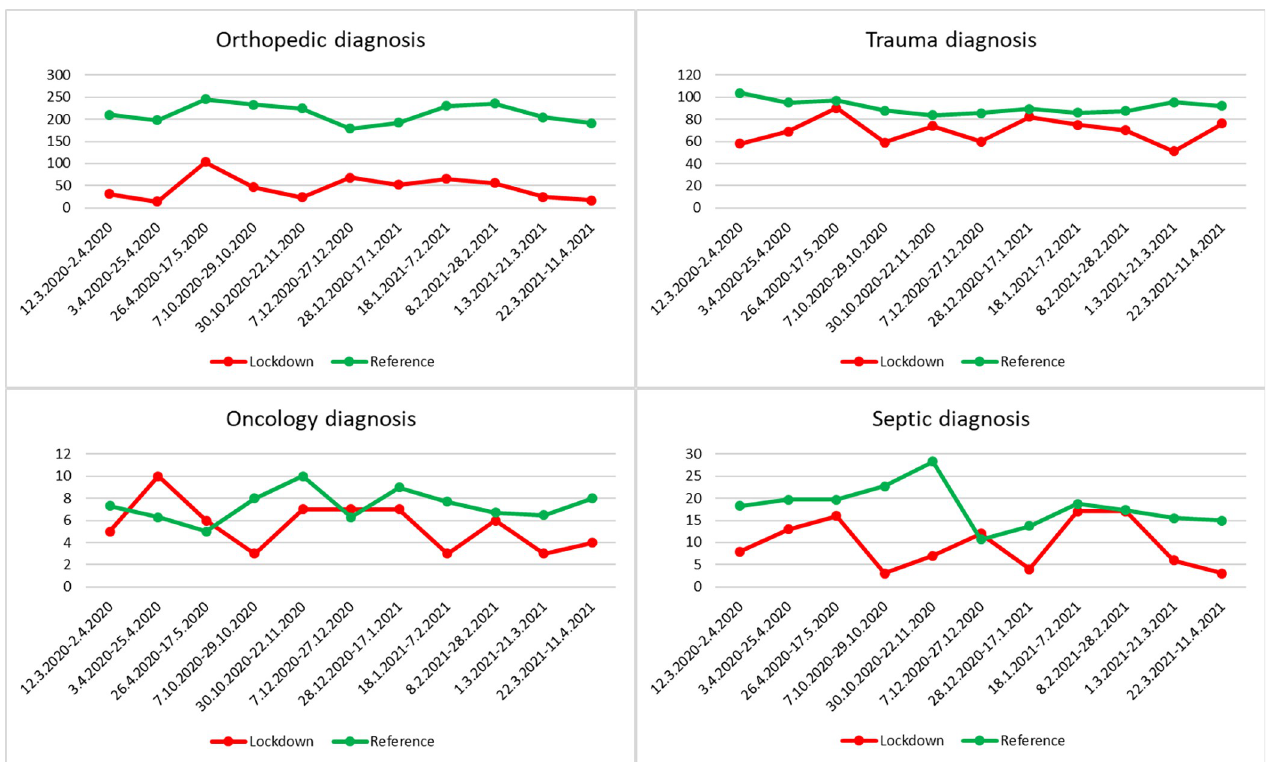
Fig 3. Admission diagnoses. Numbers (y-axis) of individual admission diagnoses during the lockdown period and reference period. For the reference period, the average of the previous 3 years before the pandemic is calculated.